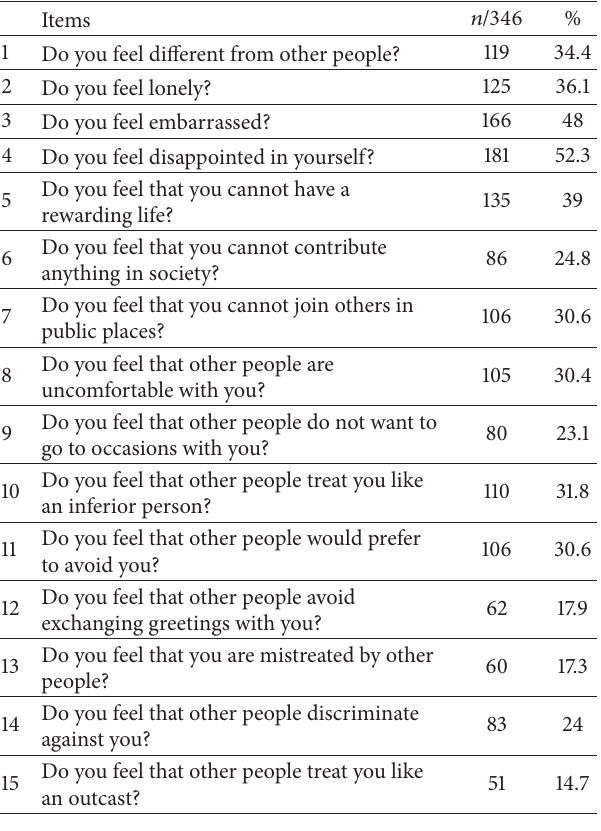
Table 4: Proportion of responses to KSSE by study participants.